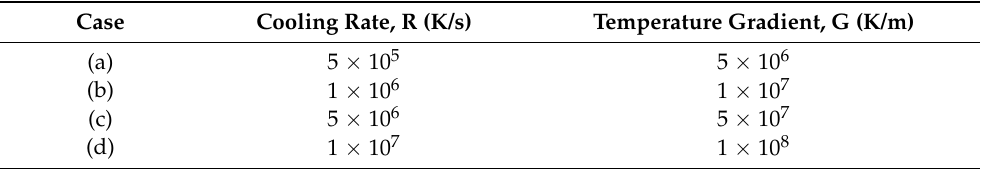
Table 1. Variations in cooling rate and temperature gradient at a steady interface growth rate (0.1